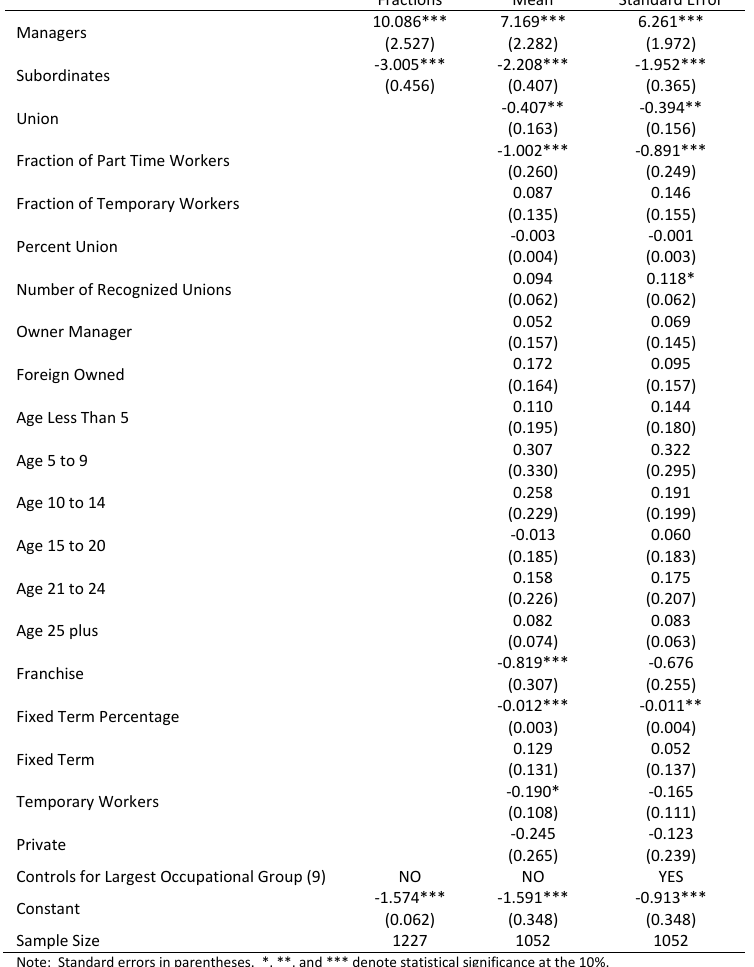
Table 6: OLS Models (Dep. Var. = ln [ Fraction High Wage / ( 1 ‐ Fraction High Wage)]